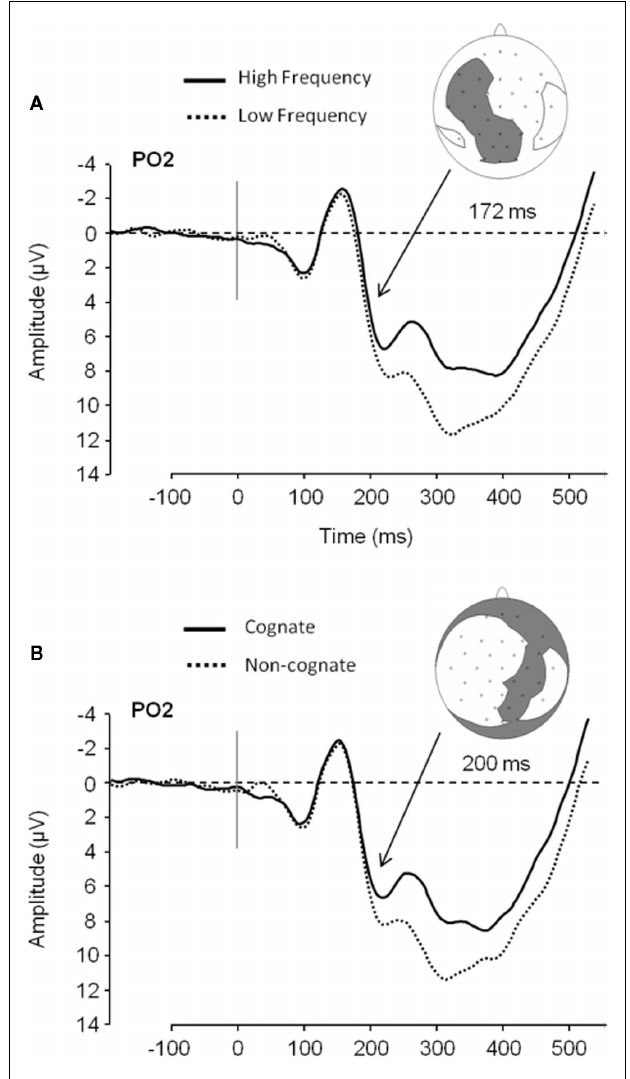
FIGURE 3 | ERP data plotted for word frequency and cognate status in overt object naming. (A) Low frequency ERPs compared to high frequency ERPs in Experiment 1 at PO2 and the electrodes showing a significant effect at 172ms after picture presentation (gray area; it does not represent the topography of the effect). (B) Non-cognate ERPs compared to cognate ERPs in Experiment 1 at PO2 and distribution of electrodes showing a significant effect at 200ms after picture presentation (gray area). (Figure taken from Experiment 1 in Strijkers et al., 2010).